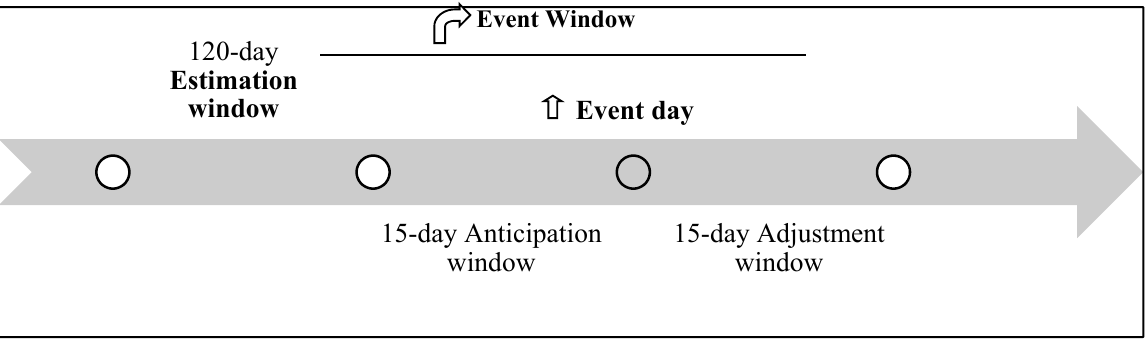
Figure 2. Timeline of the event window (source: the authors). Step 2: Calculate abnormal returns